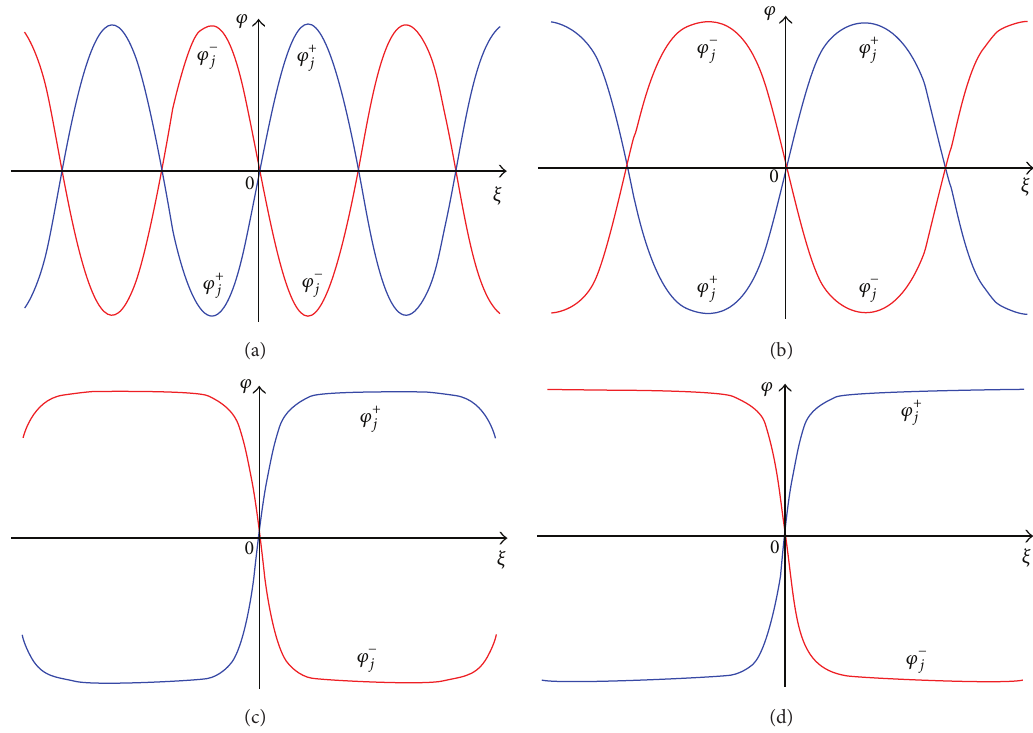
Figure 14: (The two tall-kink waves are bifurcated form two periodic waves.) The varying process for the figures of 𝜑 ± 𝑗 when (𝑞, 𝑝) ∈ 𝐴 11 and : 𝑝 = 𝑞 2 /4𝑟 = −4 and (a) 𝑝 = −3.5 , (b) 𝑝 = −4 + 10 −1 , (c) 𝑝 = −4 + 10 −3 , and (d) 𝑝 = −4 + 10 −5 𝑝 → 𝑞 2 /4𝑟 + 0 , where 𝑟 = −1 , 𝑞 = 4, and 𝑙 7